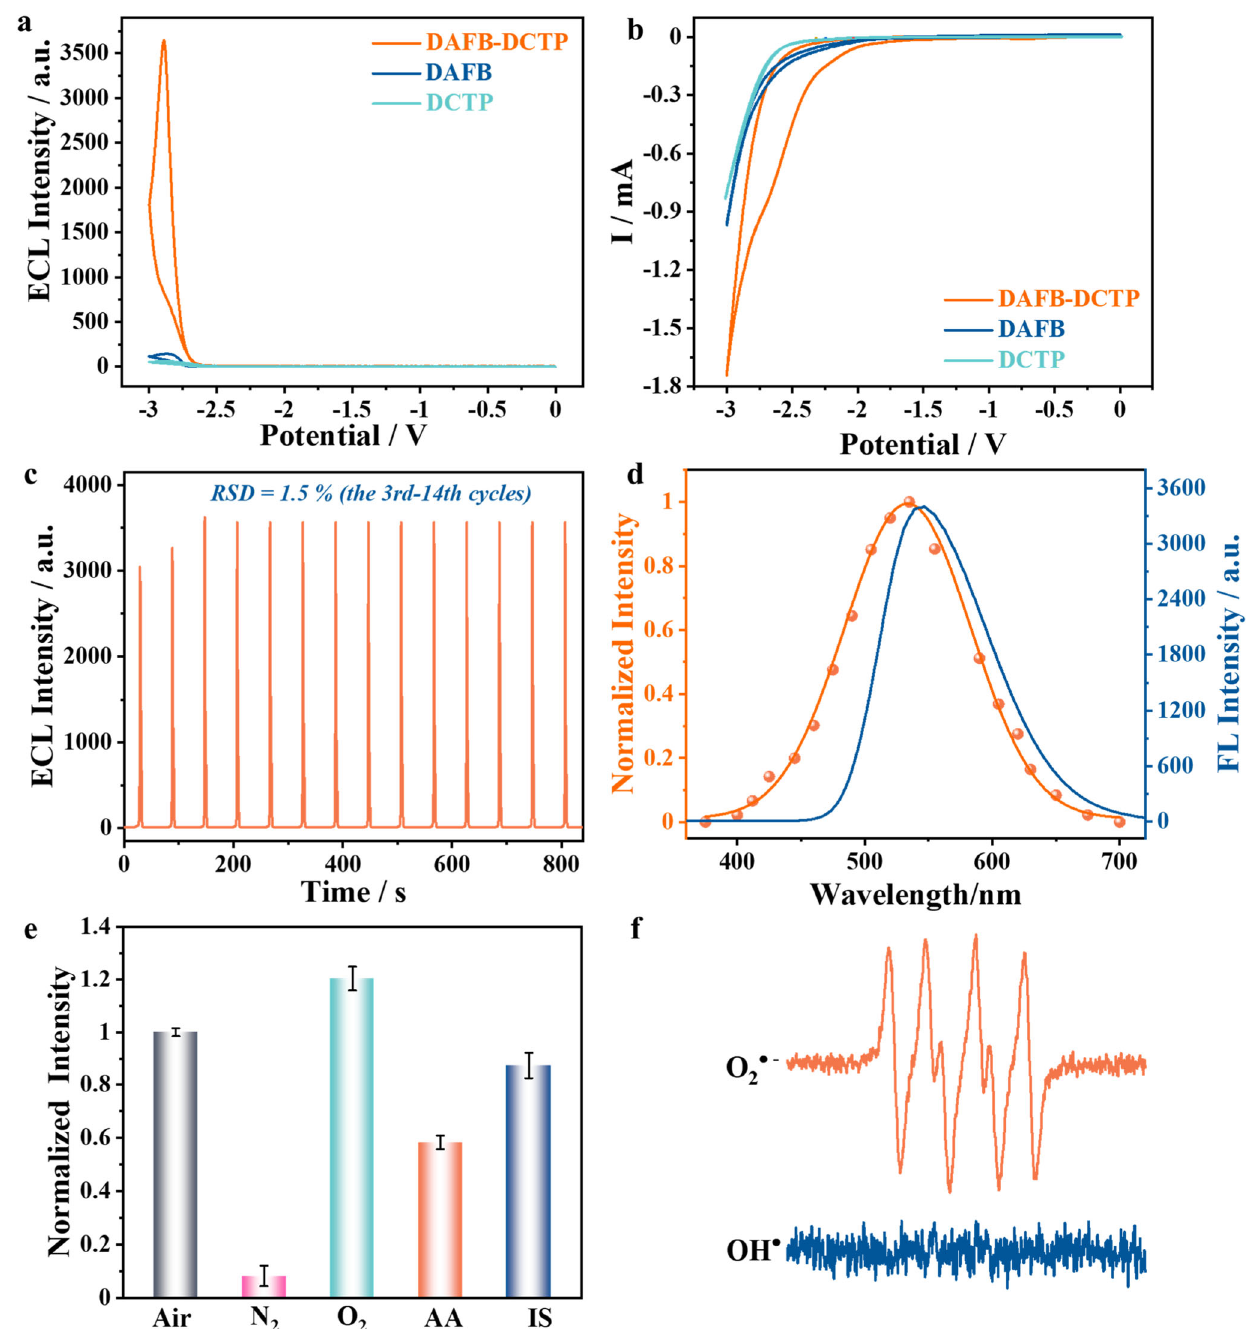
Fig. 6 Exploration of electrochemical and ECL mechanism from COFs. a ECL spectra and b corresponding CVs of DAFB-DCTP (orange curve), DAFB (blue curve), and DCTP (green curve) modi fi ed GCE. c The ECL signals of DAFB-DCTP/GCE under a continuous potential scan. d ECL spectrum of DAFB-DCTP/ GCE (orange curve) and FL spectrum of DAFB-DCTP in DMF (blue curve). e The normalized ECL intensity of DAFB-DCTP/GCE in the buffer solution containing air, N 2 -saturated, O 2 -saturated, 0.1 mM AA, or 0.1 mM IS. Error bars represent S.D. n = 3 independent experiments. f The EPR spectra of DAFB- DCTP. All the buffer solutions throughout the ECL/CV experiments were 0.1 M PBS with 0.1 M KCl between 0 V and − 3.0 V, pH 7.5, PMT: 800 V, potential scan rate: 100 mV s − 1